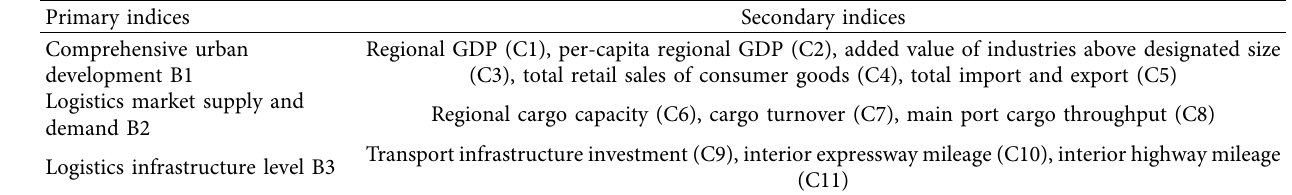
Table 1: AHP model for logistics influencing